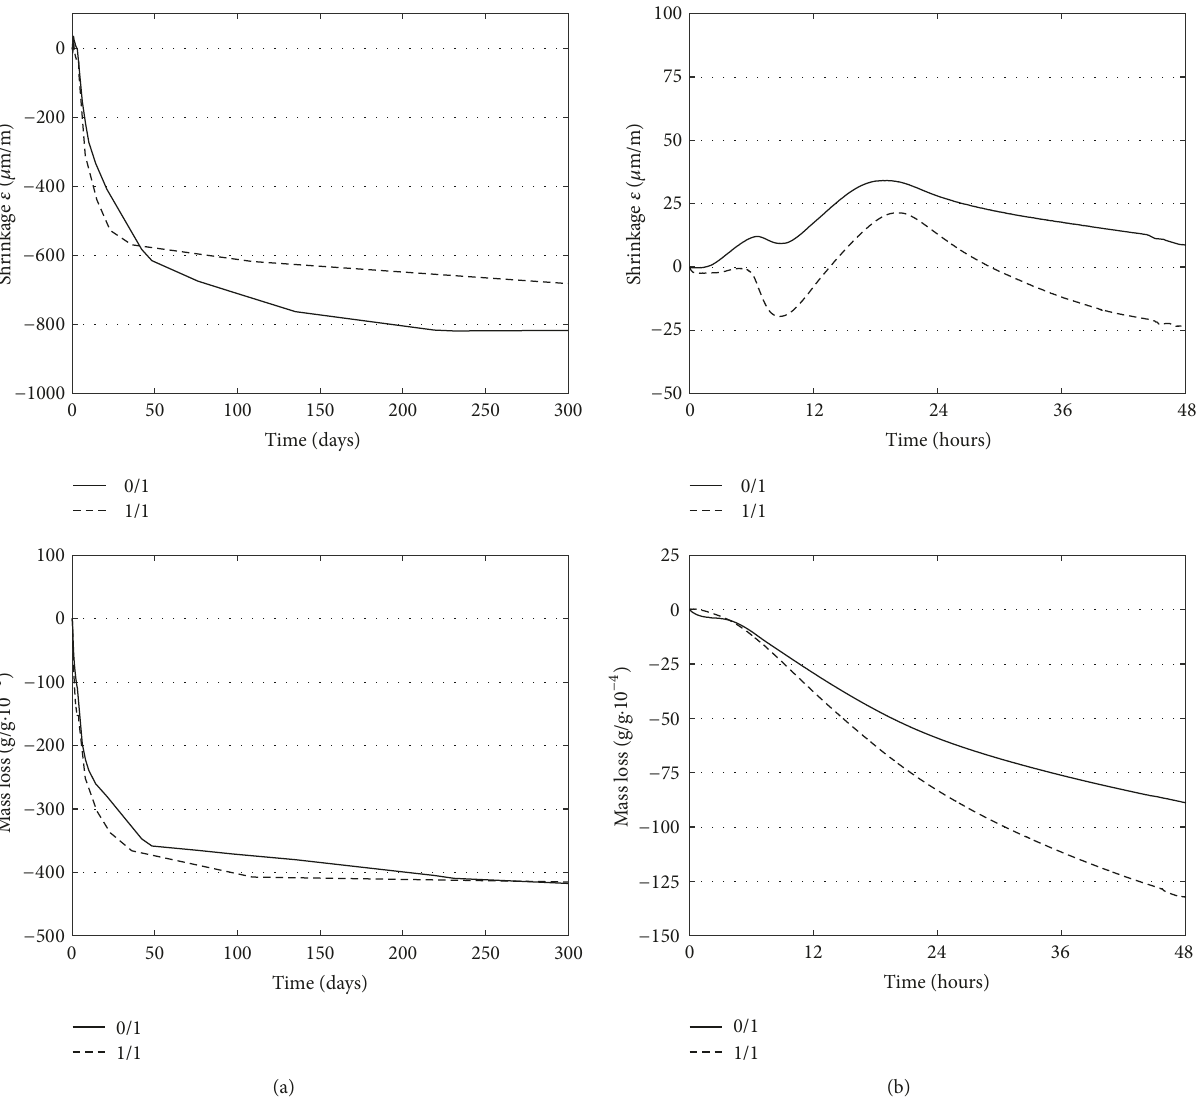
Figure 5: Progress of shrinkage/swelling and mass loss for concretes 0/1, and 1/1 ((a): measurement over the whole time of setting and hardening; (b): early age